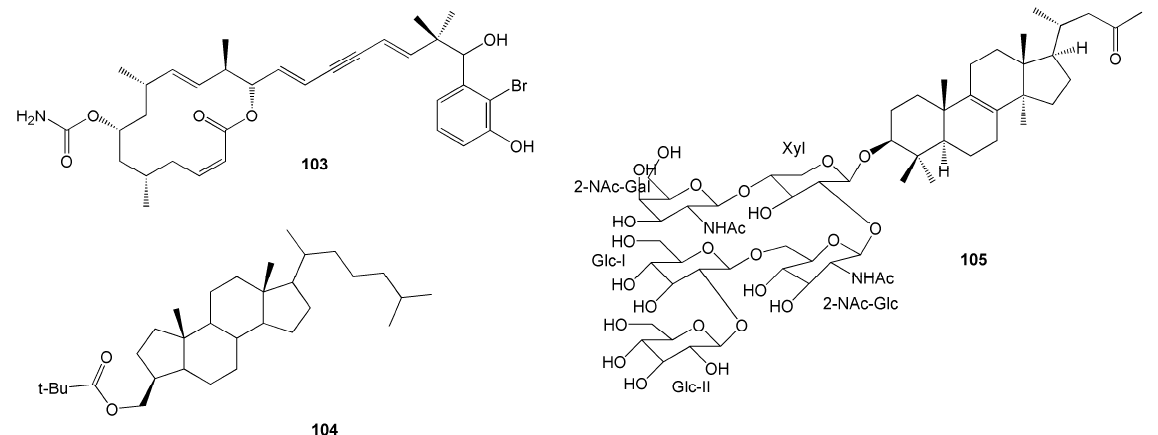
Figure 9. Chemical structures of 103 – 105.